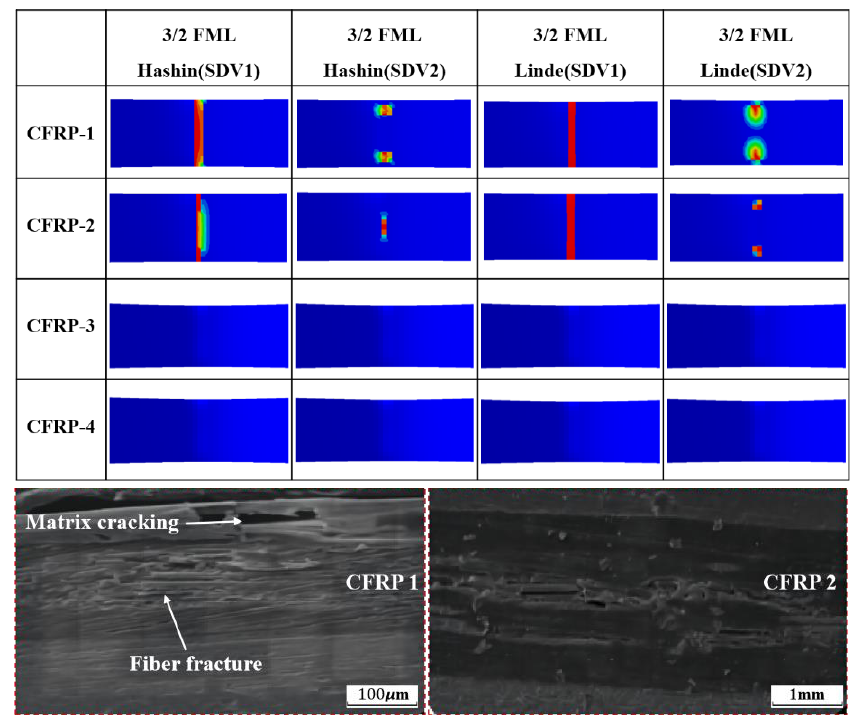
Figure 11. Damage of each CFRP layer in 3/2 FMLs